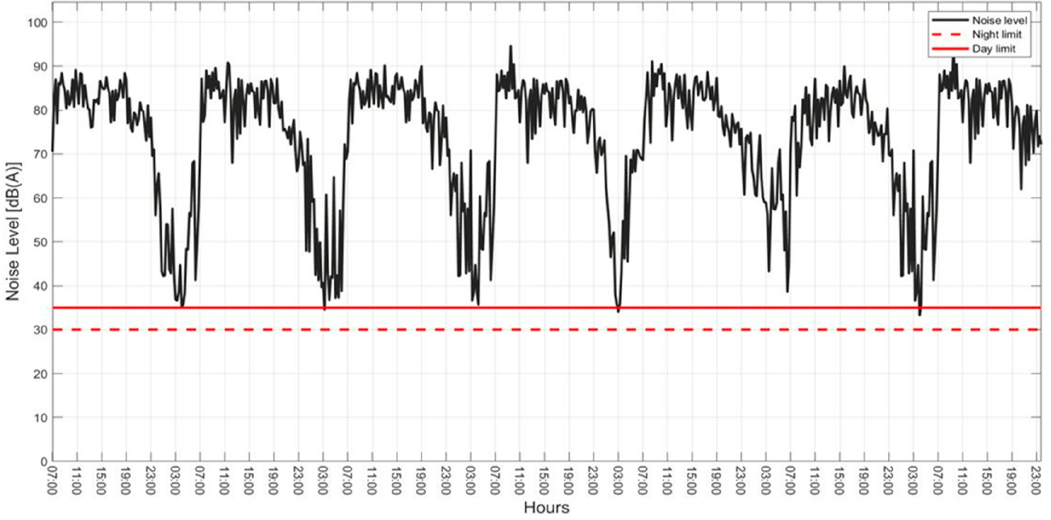
Table 6. Noise equivalence levels for the day, evening, and night times on each day.